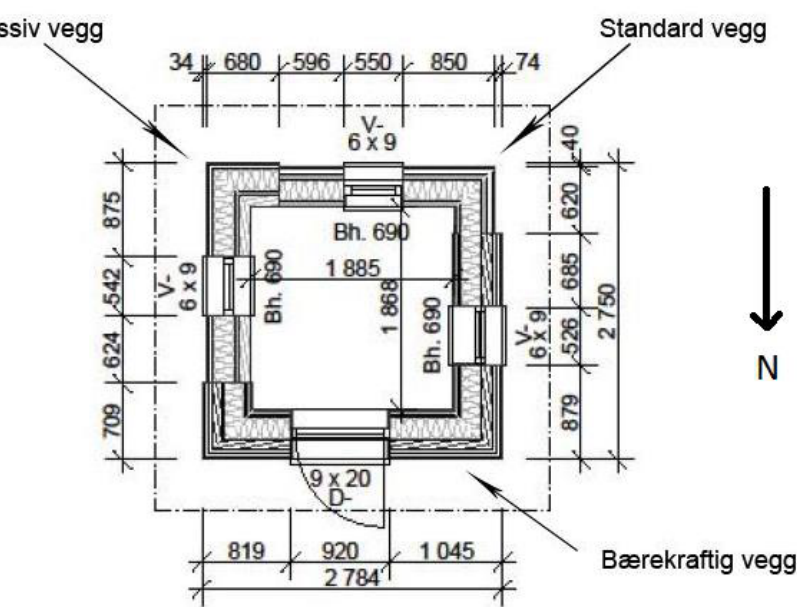
Figure 3. Plan of the test building. Measurements are in mm